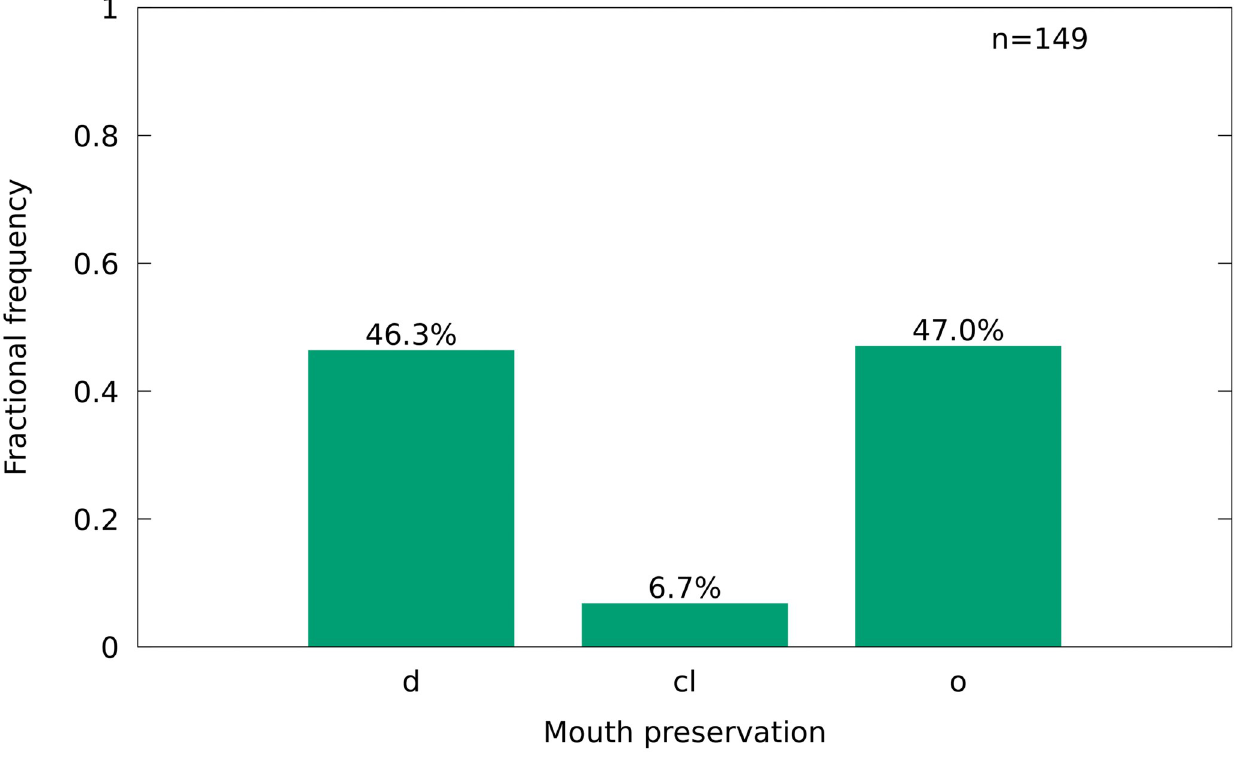
Fig 12. Mouth preservation of T . formosa , in percent of the total number. Disarticulated (d), closed (cl) and open (o).